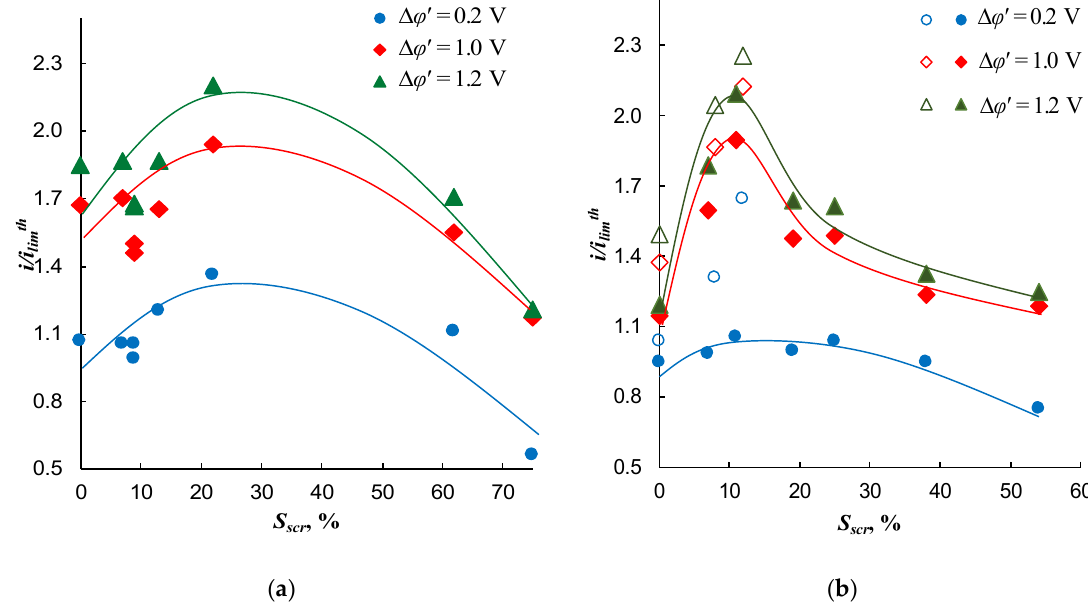
Figure 9. Dependence of the i / i th ratio on the fraction of the screened surface for the pristine and modified AMX-Sb ( a ) and AMX ( b ) membranes at the fixed values of the reduced potential drop, ∆ ϕ ’ : 0.2 V (circles), 1.0 V (diamonds), and 1.2 V (triangles). The filled symbols refer to our measurements; the open symbols refer to the results reported in [21]. Lines are drawn to guide the eye.